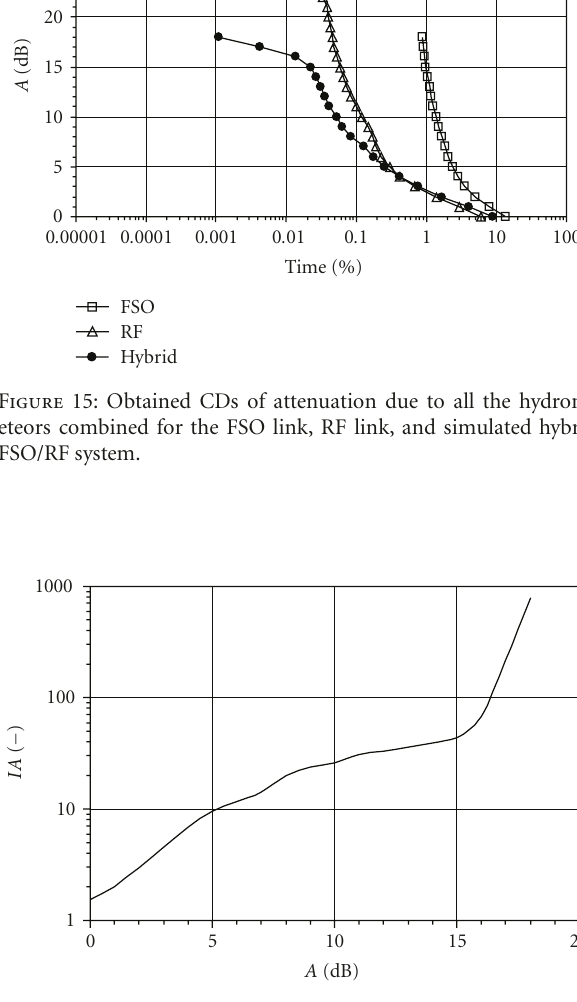
Figure 16: Obtained diversity improvement factor.